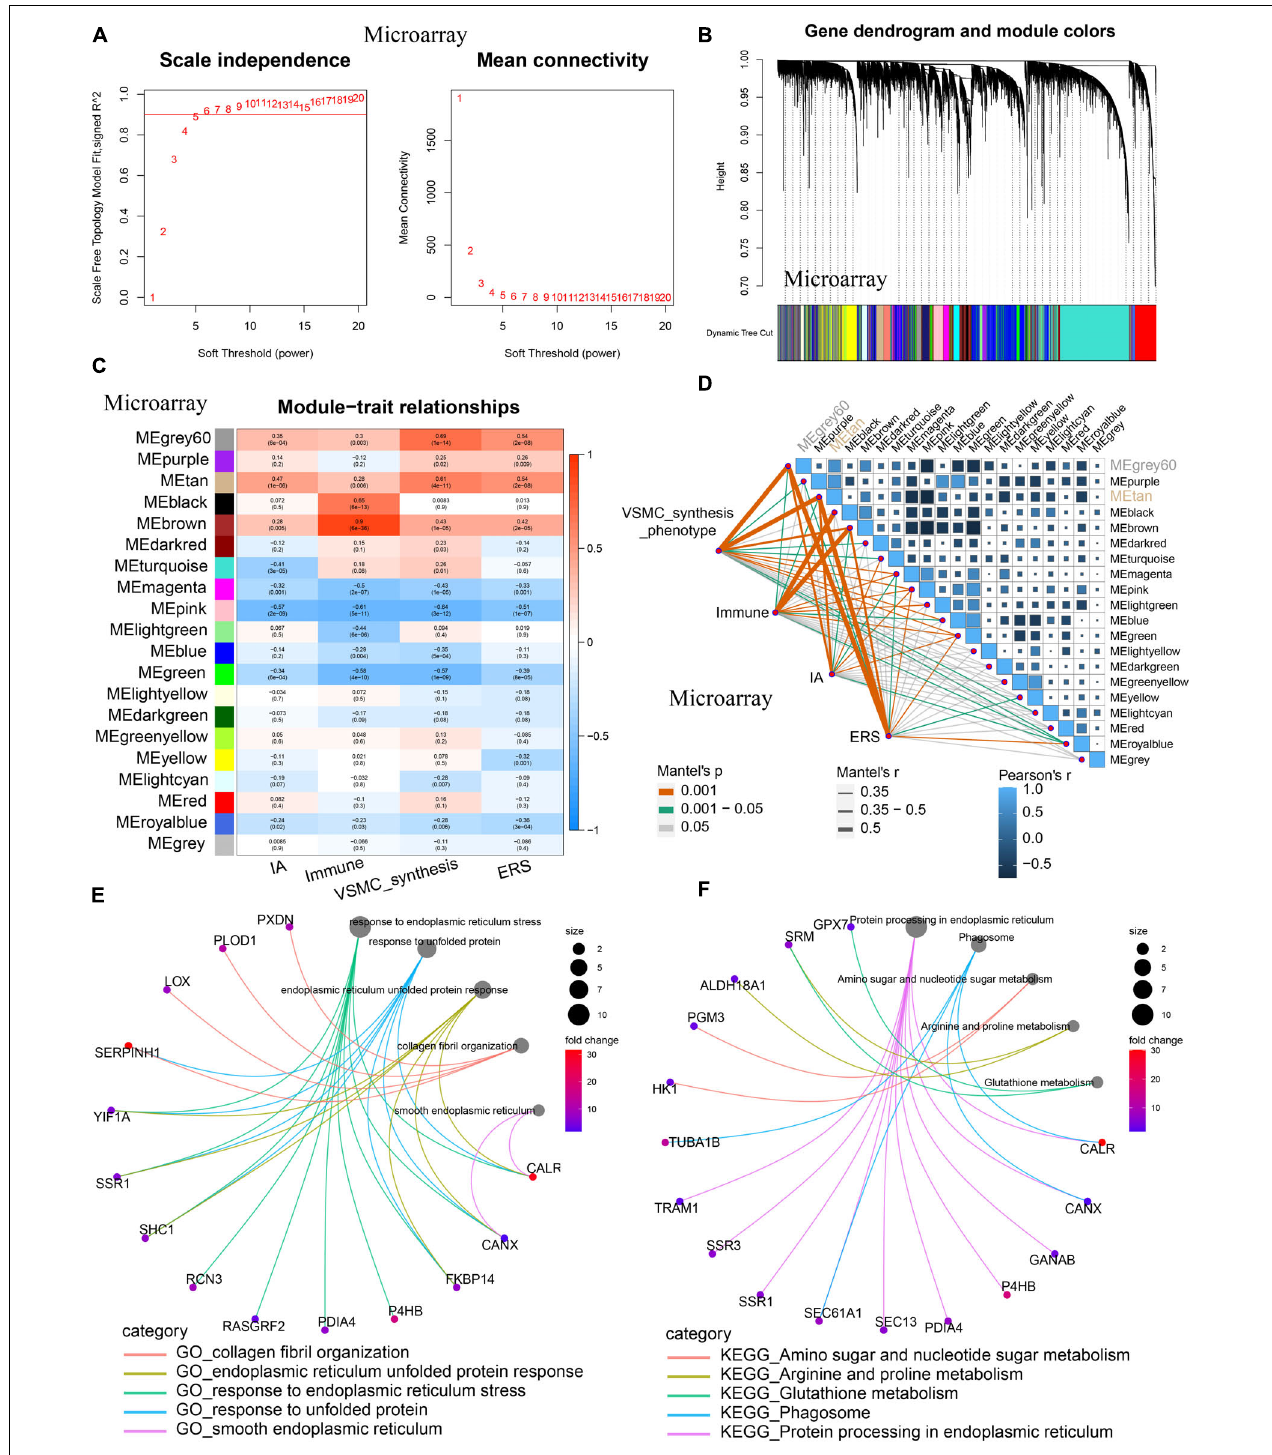
FIGURE 7 | Co-expression analysis identifying ERS-related VSMC phenotype genes in the training cohort. (A) A scale-free network construction (power threshold β = 5). (B) Gene dendrogram generating gene modules. (C) and (D) Correlation analysis between modules and pathophysiological traits. IA occurrence, VSMC synthesis, and ERS had the same two highest correlation modules (MEgray60 and MEtan). (E) GO enrichment analysis of the intersection between the training cohort (MEgray60 and MEtan) and the validating cohort (MEbrown and MEpink). (F) KEGG enrichment analysis of the intersection between the training cohort (MEgray60 and MEtan) and (MEbrown and MEpink). Function enrichment showed that these modules mainly focused on smooth endoplasmic reticulum, collagen fibril organization, metabolism, and phagosome.